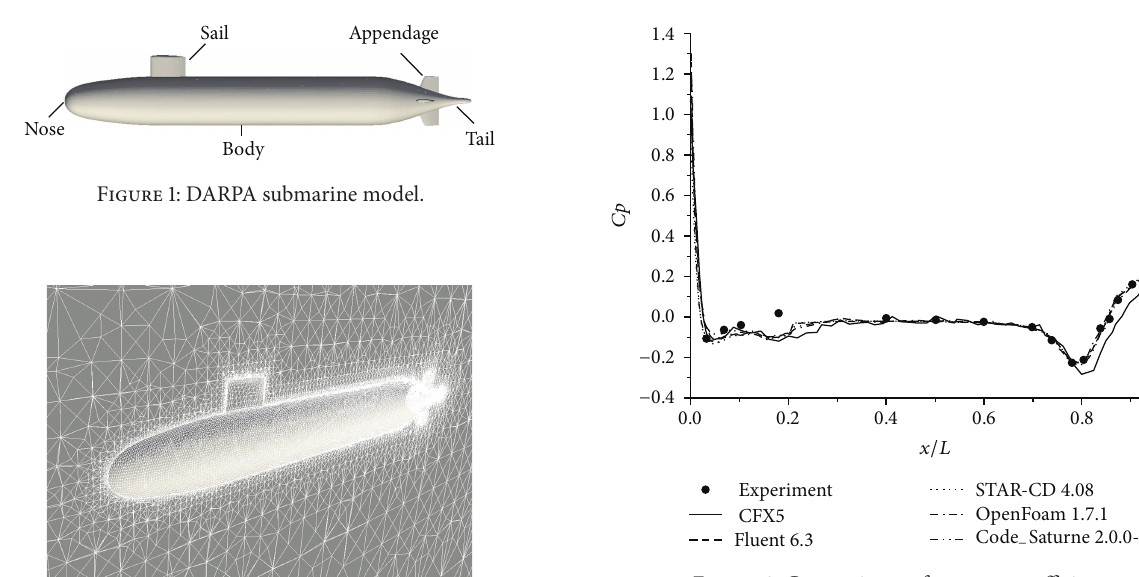
Figure 3: Comparisons of pressure